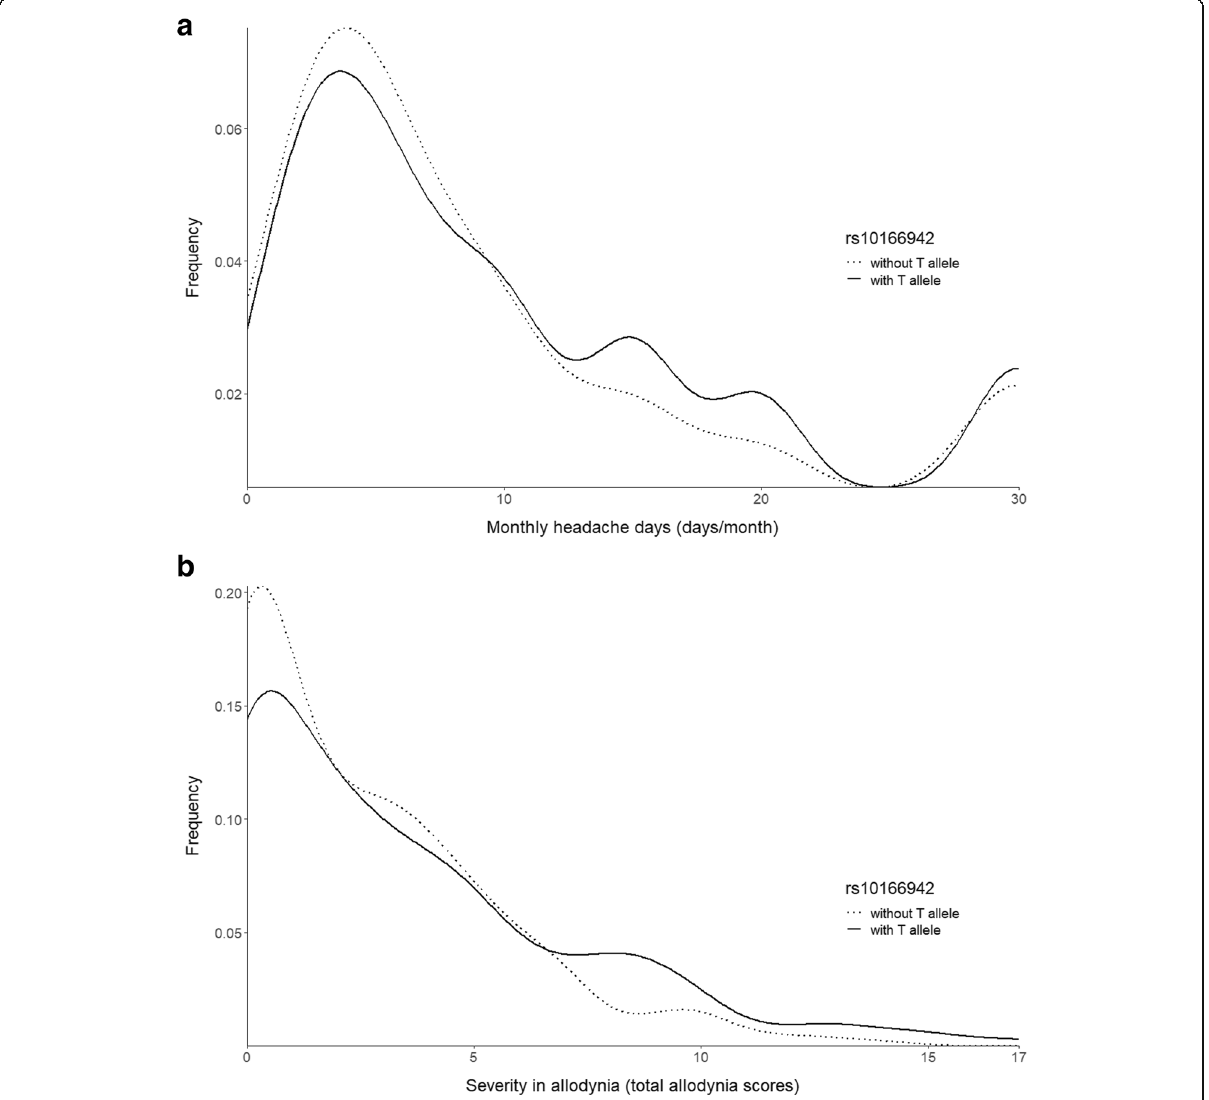
Fig. 2 a The distribution of headache frequencies in migraineurs with or without T allele in rs10166942. b The distribution of allodynia severity in migraineurs with or without T allele in